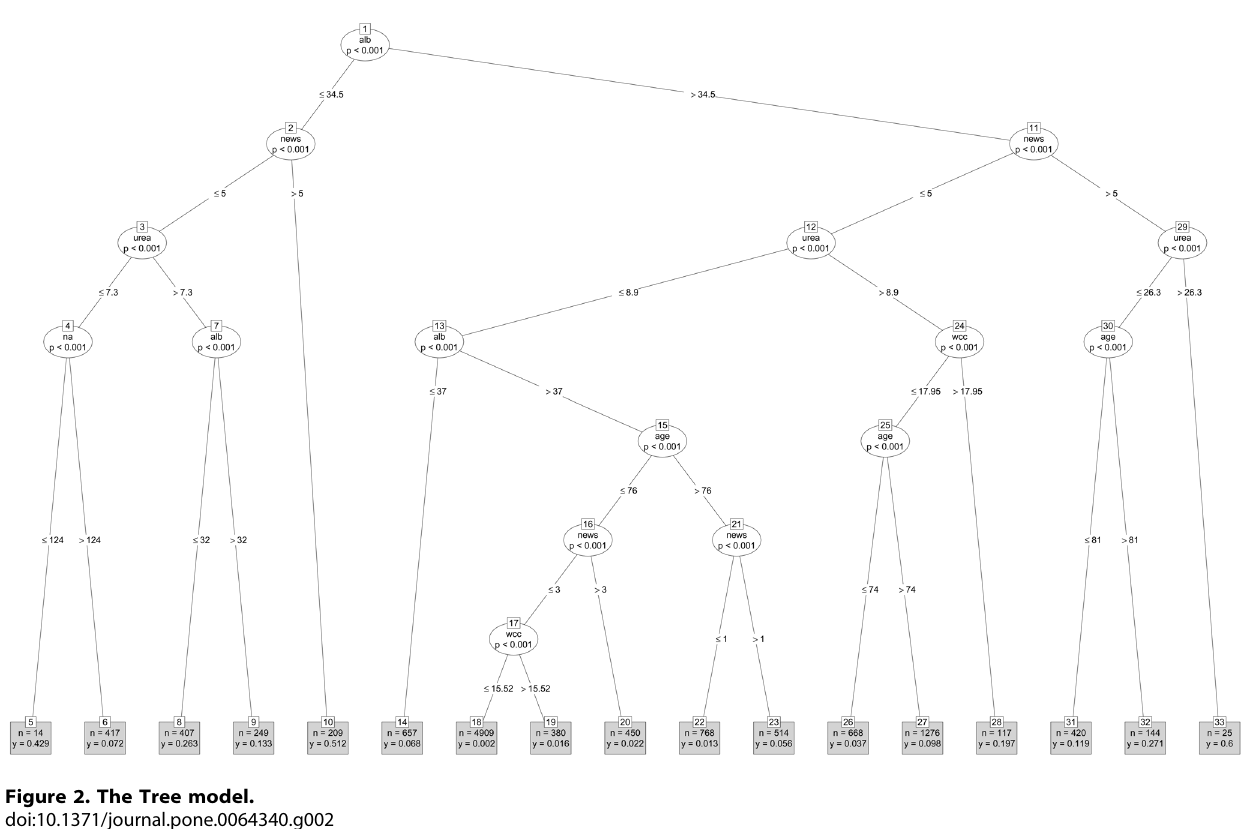
Figure 2. The Tree model.